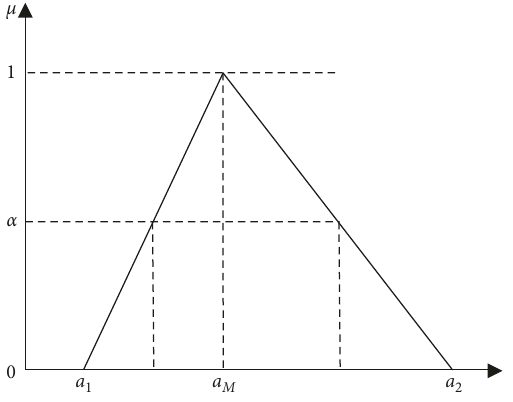
Table 2: Fuzzy triangular scale for fuzzy AHP.